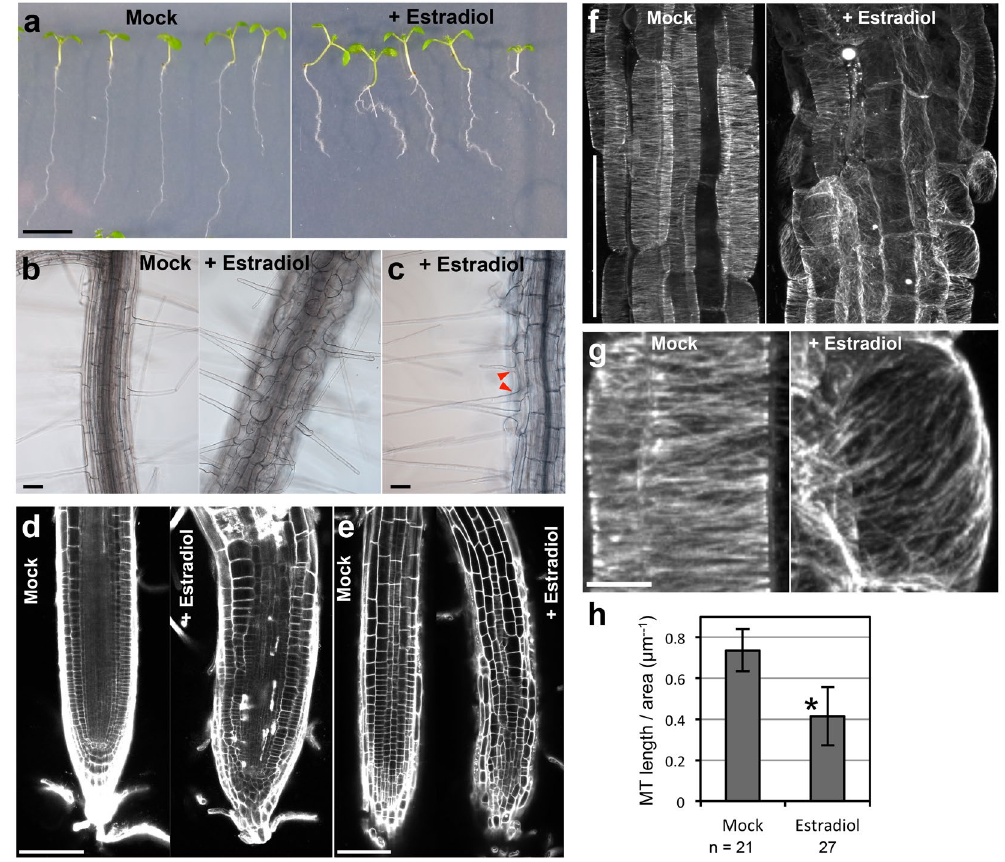
Figure 4. NEK6 overexpression disorganizes cortical microtubules and suppresses cell elongation. ( a ) Morphology of seedlings harboring estrogen-inducible NEK6 . Seedlings were grown vertically for 8 days in the absence (Mock) or presence of estradiol ( + Estradiol). The scale bar represents 1 cm. ( b , c ) Effect of NEK6 overexpression on epidermal cell morphology. Roots of seedlings grown for 8 days without (Mock) or with estradiol ( + Estradiol) were observed under a microscope. Arrowheads indicate two root hairs in a trichoblast in the presence of estradiol. Scale bars represent 100 µ m. ( d , e ) Middle-vertical section ( d ) and epidermal cells ( e ) of the root tip. The roots of seedlings grown for 8 days without (Mock) or with estradiol ( + Estradiol) were stained with propidium iodide and observed under a confocal microscope. Scale bars represent 100 µ m. ( f ) Effect of NEK6 overexpression on cortical microtubule arrays. The seedlings grown for 4 days without (Mock) or with estradiol ( + Estradiol) were stained with anti- β -tubulin antibody. Fluorescence images show cortical microtubules in root epidermal cells in the elongation region. The scale bar represents 100 µ m. ( g ) Enlarged view of cortical microtubule arrays in ( f ). The scale bar represents 10 µ m. ( h ) Quantification of cortical microtubule density without (Mock) or with estradiol ( + Estradiol). Data are displayed as averages ± SDs. The asterisk indicates significant difference from the value in mock-treated plants ( t -test, P <